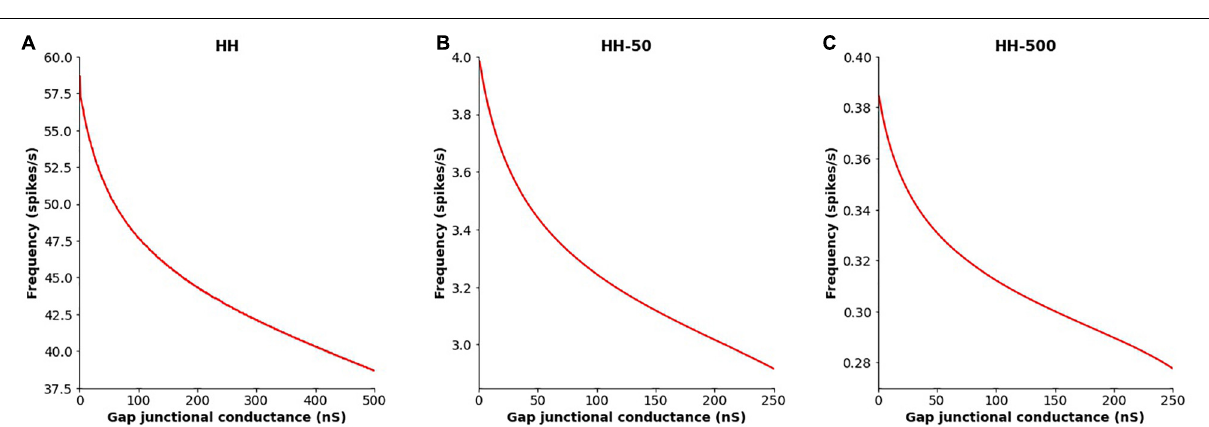
FIGURE 4 | Variation in the frequency of AP oscillations, observed at the central cell in the 1-D chain of cells, with changes in the extent of intercellular coupling with (A) HH AP mechanism, (B) HH-50 AP mechanism, and (C) HH-500 AP mechanism. Similar trends are observed for all these variants, with the oscillation frequency falling with increased gap junctional coupling between